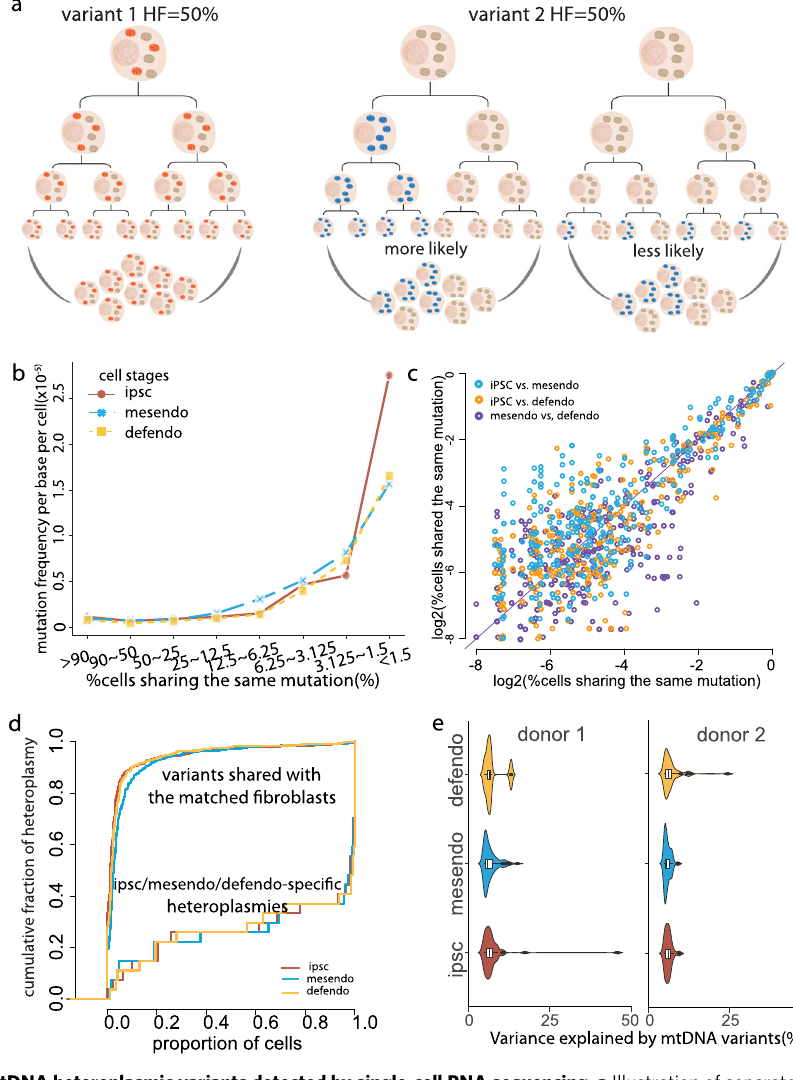
Fig. 5 Characteristics of mtDNA heteroplasmic variants detected by single-cell RNA sequencing. a Illustration of separate models explaining the variants with the same pseudo-bulk heteroplasmy level. A variant with 50% HF could be due to 100% of cells carrying ~50% HF heteroplasmic variants (left). Alternatively, a variant with 50% HF could be due to 50% of cells carrying homoplasmic variants in the population (right two graphs). In the middle, the variant was passed from the same ancestral cell. On the right, the variant mutated independently in a large proportion of cells. b The proportion of cells carrying the same variant from each cell line was grouped into different bins. Line plots show the distributions of the mutational rates estimated within each bin (where mutational rate = number of mutations within each bin from the same cell line divided by the number of cells from each cell line multiplied by 16569 (bp)). The mutational frequency pro fi les were consistent between the three cell stages. Cells de fi ned as iPSCs, mesendo and defendo cells are shown in different colours. c Scatter plots of the log2 percentage of cells carrying the same variant from each cell line between any two of three cell stages. The HF for each individual mutation was highly correlated across all three cell stages. Source data are provided as a Source Data fi le . d Cumulative distribution of the heteroplasmic variants detected in each cell type. Variants shared with their matched fi broblast cell lines are shown in the upper left side, and iPSC/mesendo/defendo-speci fi c variants are shown in the lower right side. e Violin and box plots show the percentage of the variance for gene expression explained by mtDNA variants from two independent cell lines. Cells de fi ned as iPSCs, mesendo and defendo cells are shown in different